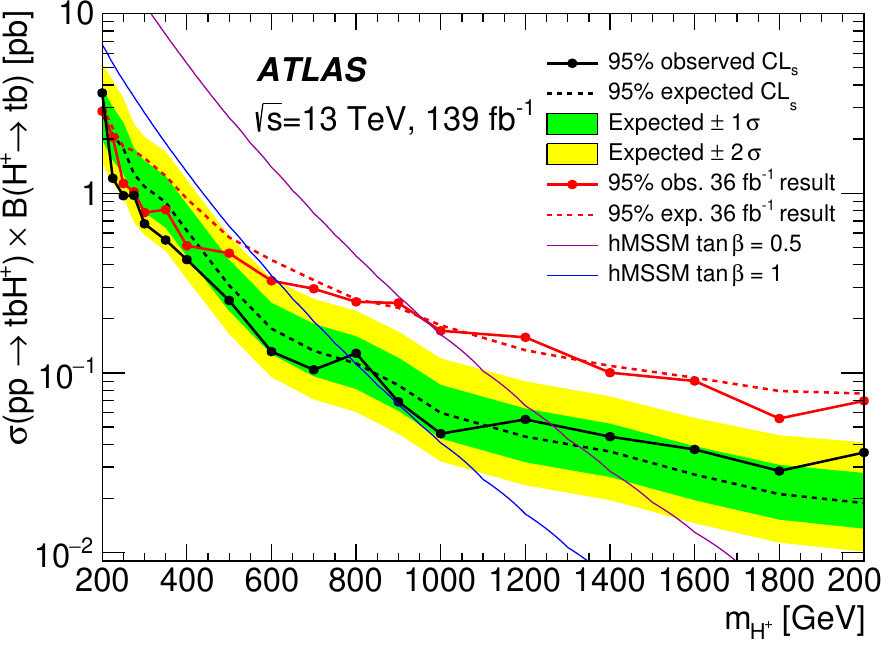
Figure 6 . Observed and expected upper limits for the production of H + → tb in association with a top quark and a bottom quark. The bands surrounding the expected limit show the 68% and 95% confidence intervals. The red lines show the observed and expected 95% CL exclusion limits obtained with the 36 fb − 1 data sample [25]. Theory predictions are shown for two representative values of tan β in the hMSSM benchmark scenario. Uncertainties in the predicted H + cross-sections or branching ratios are not